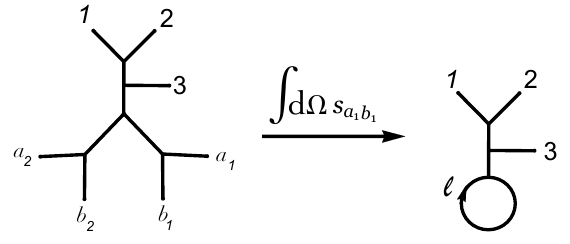
Figure 7 . One of all possible Feynman diagrams given in (cid:12)gure 6(b). Resulting tadpole after making the forward limit, i.e. by integrating R d (cid:10) ( k a